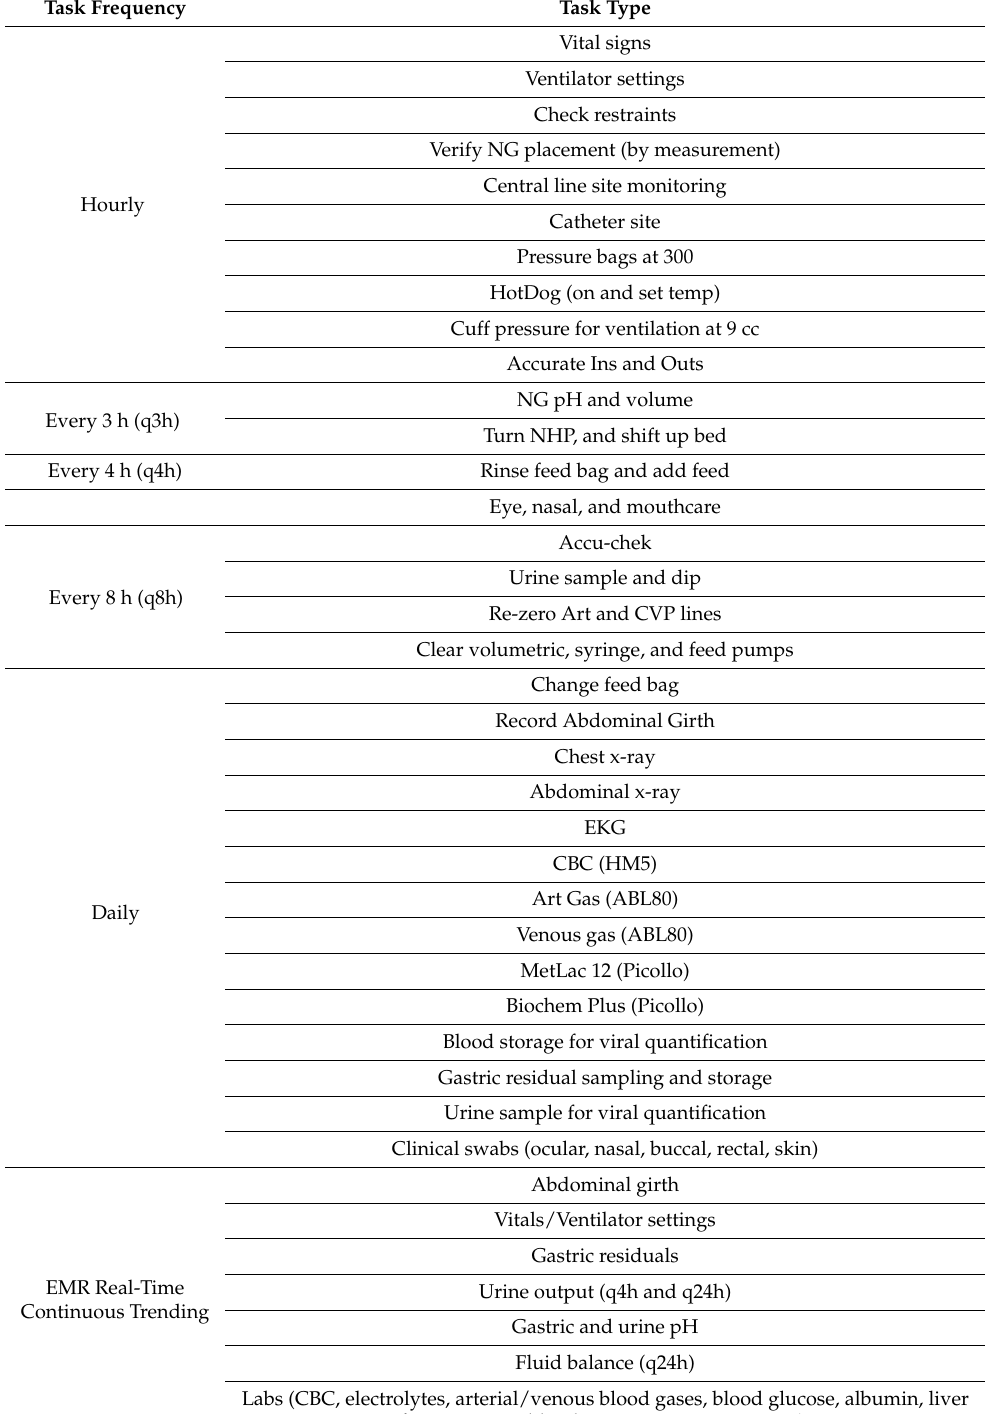
Table 1. Bedside care, monitoring, sample collection, and documentation